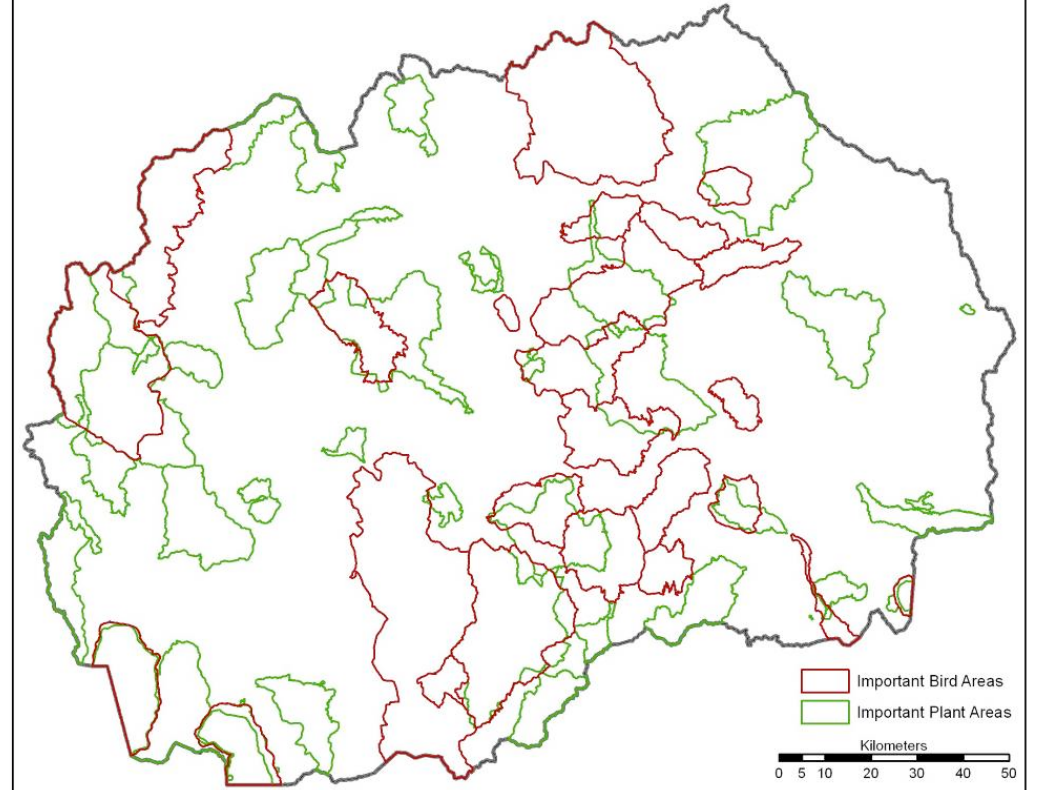
Figure 2. Important Bird Areas and Important Plant Areas in Macedonia